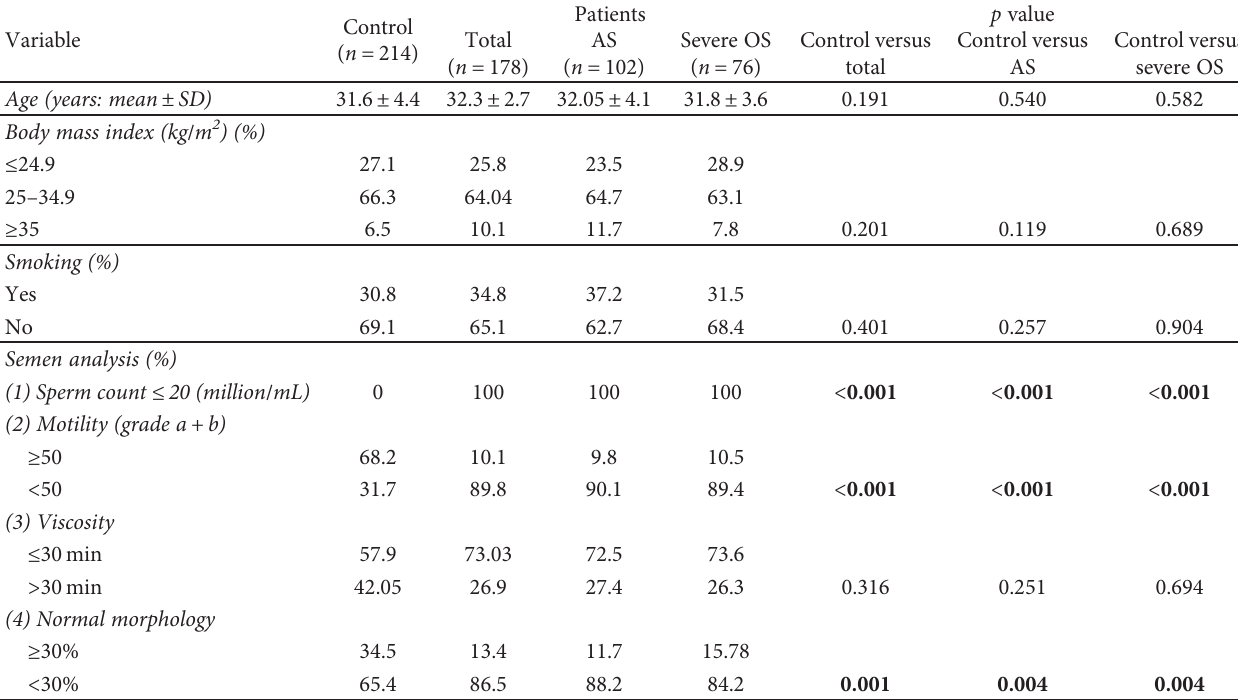
Table 1: Demographic and clinical characteristics of